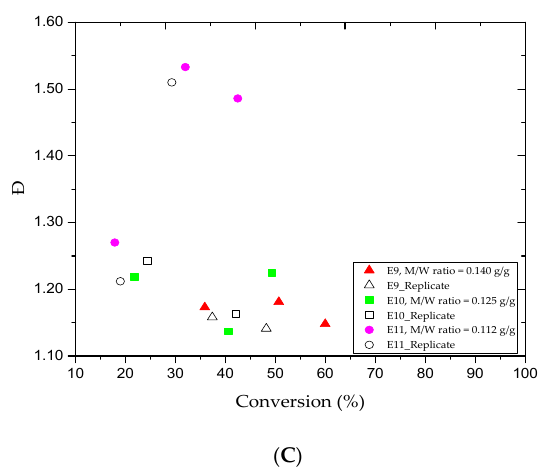
Figure 3. For experiments E9–E11: ( A ) methyl methacrylate (MMA) conversion rate versus reaction time, ( B ) variations in the experimental number-average molar mass (M n ) versus methyl methacrylate (MMA) conversions, and ( C ) variations in the polydispersity index (Ð) versus methyl methacrylate (MMA) conversions.